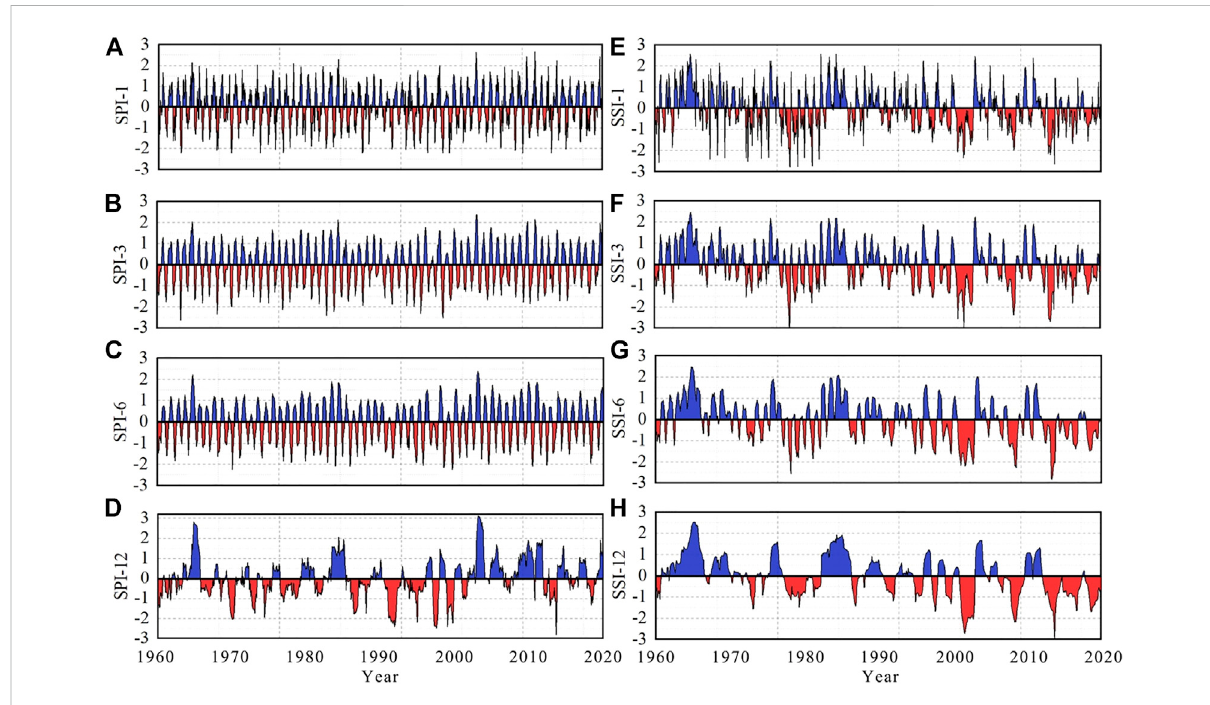
FIGURE 3 SPIandSSIvaluesondifferenttime scales (A), (B),(C), and (D) aretheSPIontime scaleof1,3,6, and12 months,respectively (E),(F),(G), and (H) are the SSI on time scale of 1, 3, 6, and 12 months,